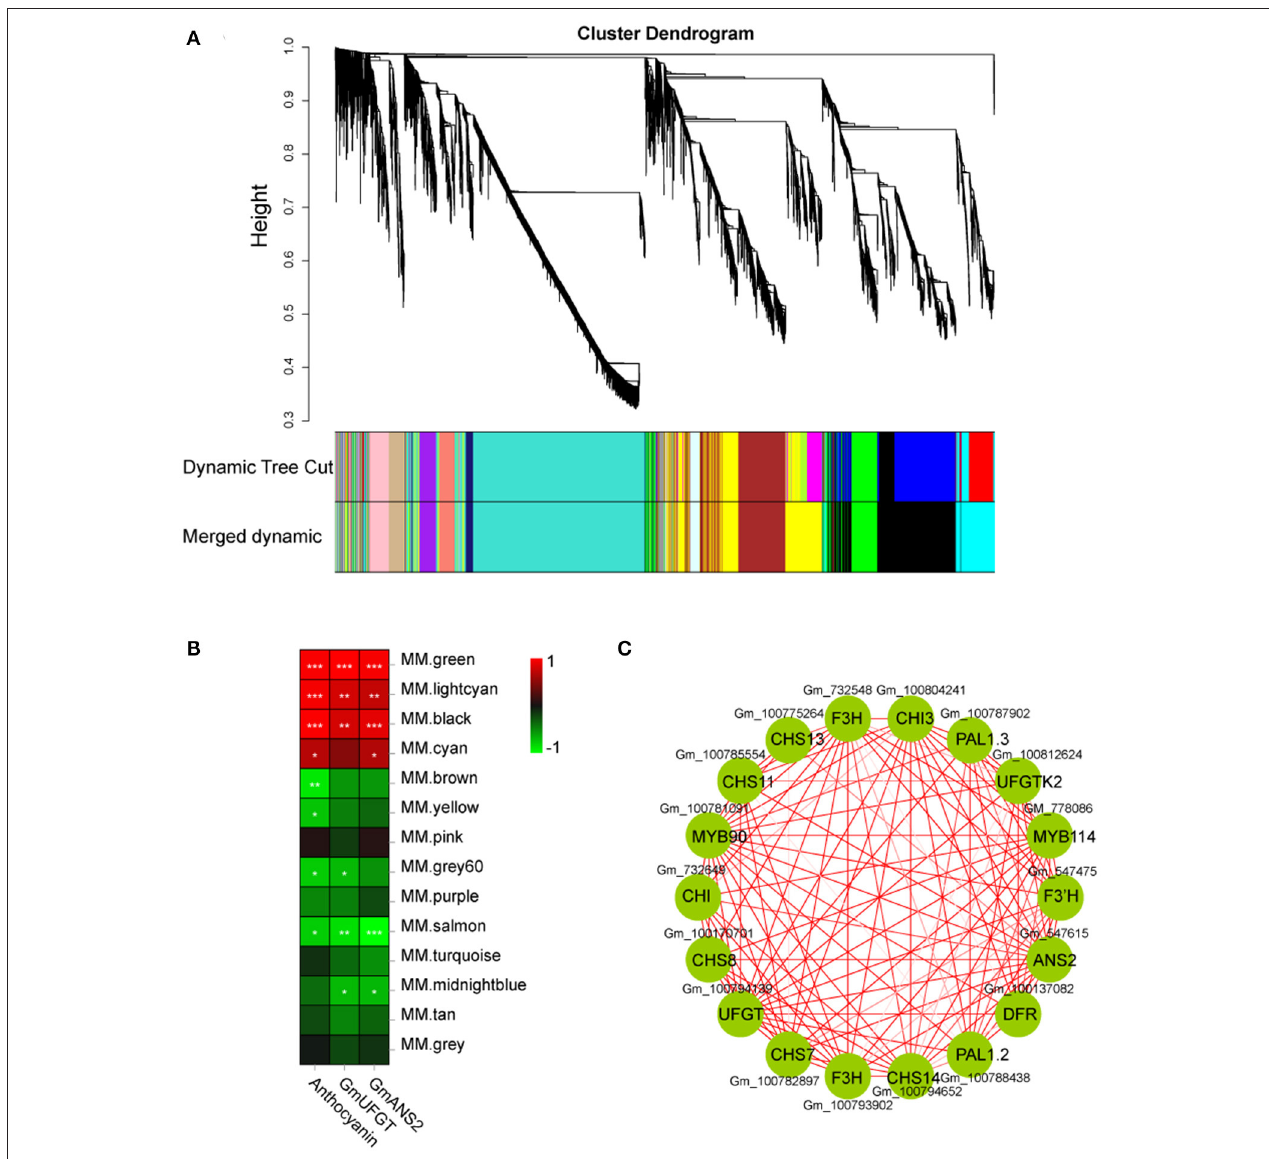
FIGURE 8 | Weighted gene co-expression network analysis of DEGs identified in soybean sprout hypocotyl. (A) Hierarchical cluster tree showing 14 modules of co-expressed genes. Each of the DEGs is represented by a leaf in tree, and each of the modules by a major tree branch. The lower panel shows modules in designated colors. (B) Module-trait correlations and corresponding significant differences. The panel shows 14 modules. The color scale indicates module-trait correlations. Panel labeled “GmUFGT,” “GmANS2,” and “Anthocyanins” as a trait. (C) Cytoscape representation of co-expressed genes with the edge weights ≥ .8 in the “MM.green” module. Member gene IDs are